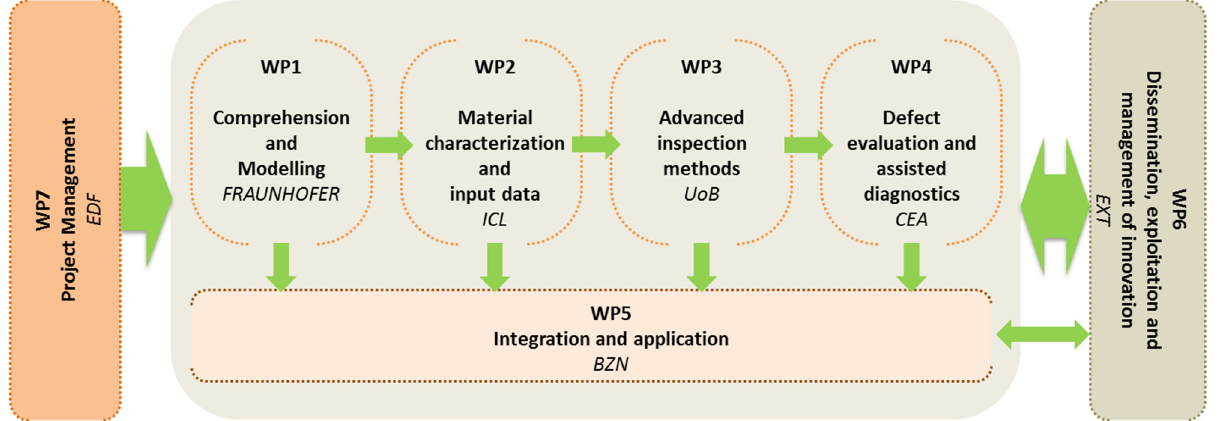
Fig. 1. ADVISE work